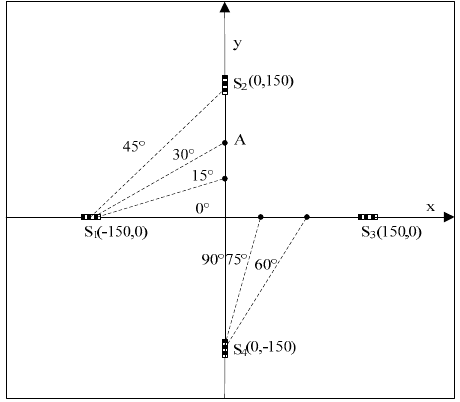
Figure 2. Measurement method of wave velocity.